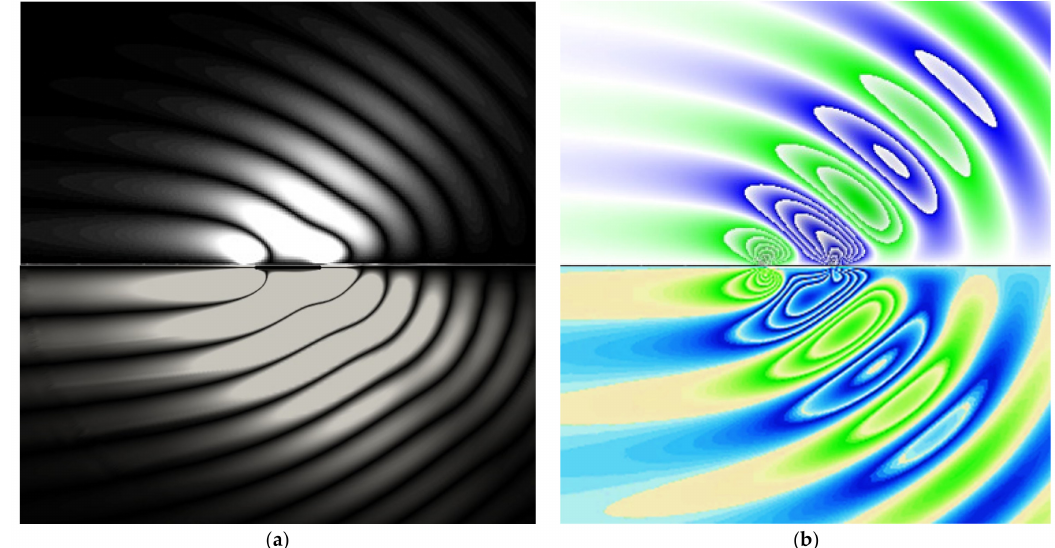
Figure 6. Internal wave field patterns around a uniformly moving horizontal plate. Numerical visualization of exact solution of the linearized problem in the underlying plane approximation (upper part of the images) and direct numerical simulation in the full non-linear formulation (lower one) T b = 14 s, L = 7.5 cm: ( a , b )— U = 0.17, 0.25 cm/s.